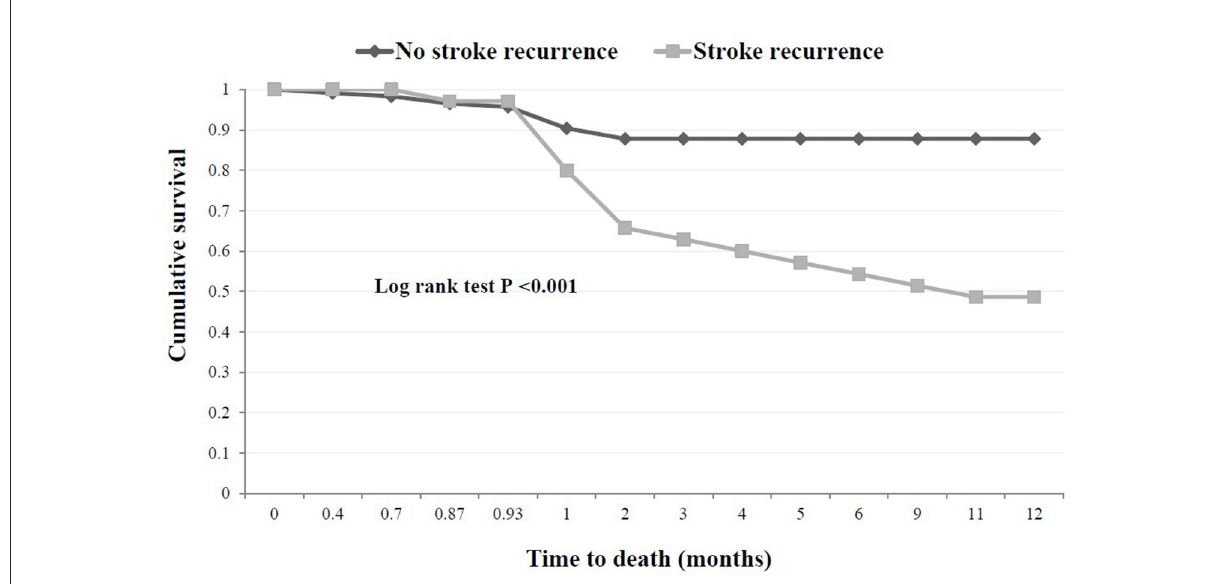
FIGURE5 Kaplan Meier estimates of 1-year probability of survival after a first-ever stroke among subjects with and without stroke recurrence. Log rank test P < 0.001.